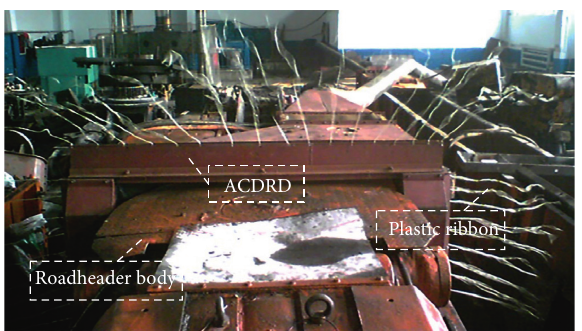
Figure 9: The location of the ACDRD on the roadheader.